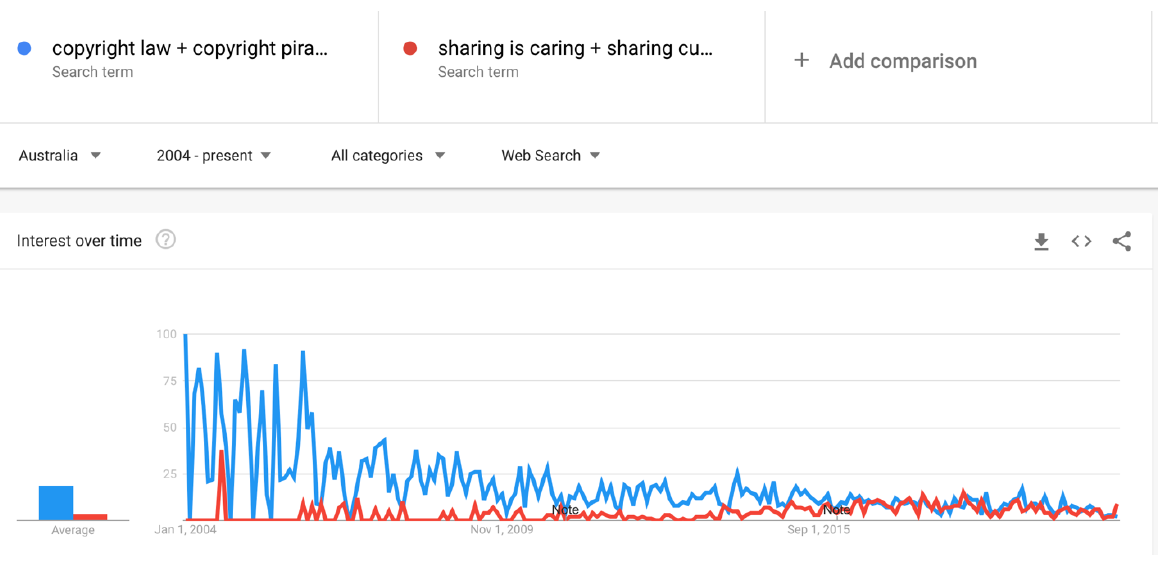
Figure 4: Comparative Search Query Index for piracy (blue) and sharing (red) (31 March 2021) Data source: Google Trends